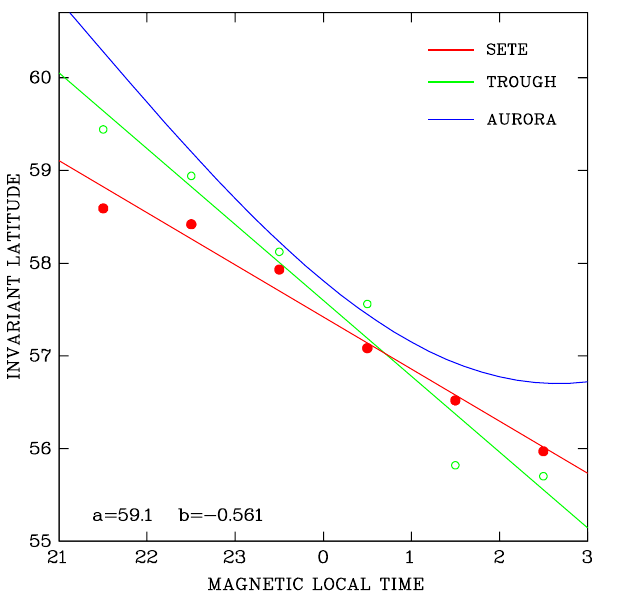
Fig. 6. Position of the subauroral electron temperature enhancement ( SET E ) as a function of magnetic local time. The red dots mark the mean position of the temperature peaks (= latm ) for each 1-h inter- val of magnetic local time during moderately strong geomagnetic activity ( Dst =–43nT, which corresponds to a Kp index of about 5). A linear regression line has been fitted to the data points (red line), and the associated fitting parameters are given in the lower left-hand corner (ordinate intersection a in degrees, slope b in de- grees/hour). The absolute magnitude of the correlation coefficient is almost 0.99. For comparison, we also show the corresponding mean values and regression line for the trough minimum (green cir- cles and green line). The blue line indicates the location of the equatorward boundary of the diffuse aurora for a Kp index of 5 (Gussenhoven et al., 1983).